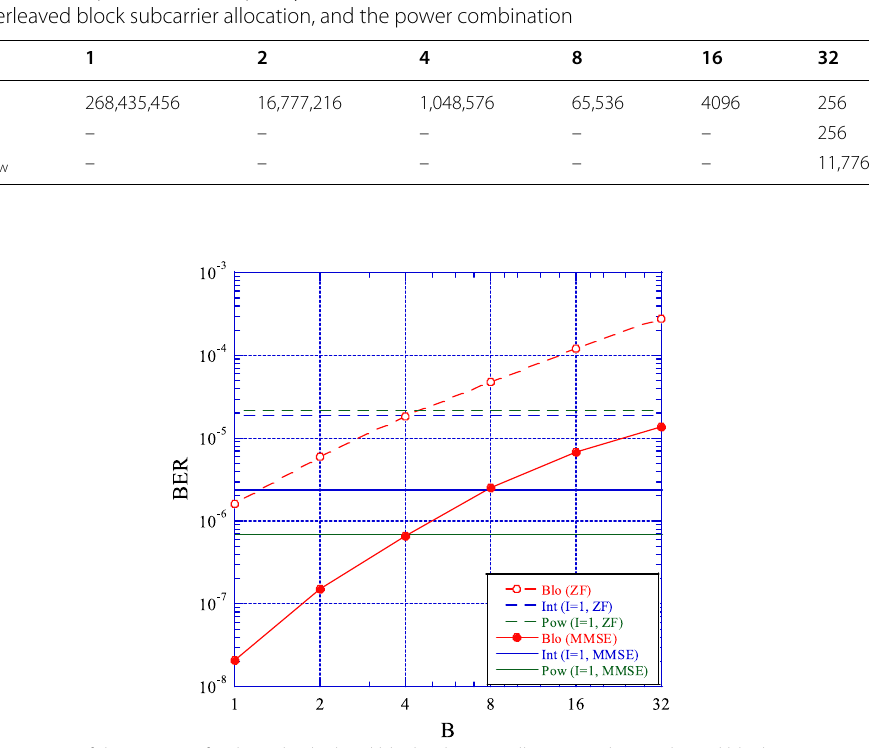
Fig. 6 BER of the various B for the individual and block subcarrier allocations, the interleaved block subcarrier allocation, and the power combination with the DFT, the ZF, and the MMSE, without the coding at E b / N 0 = 25